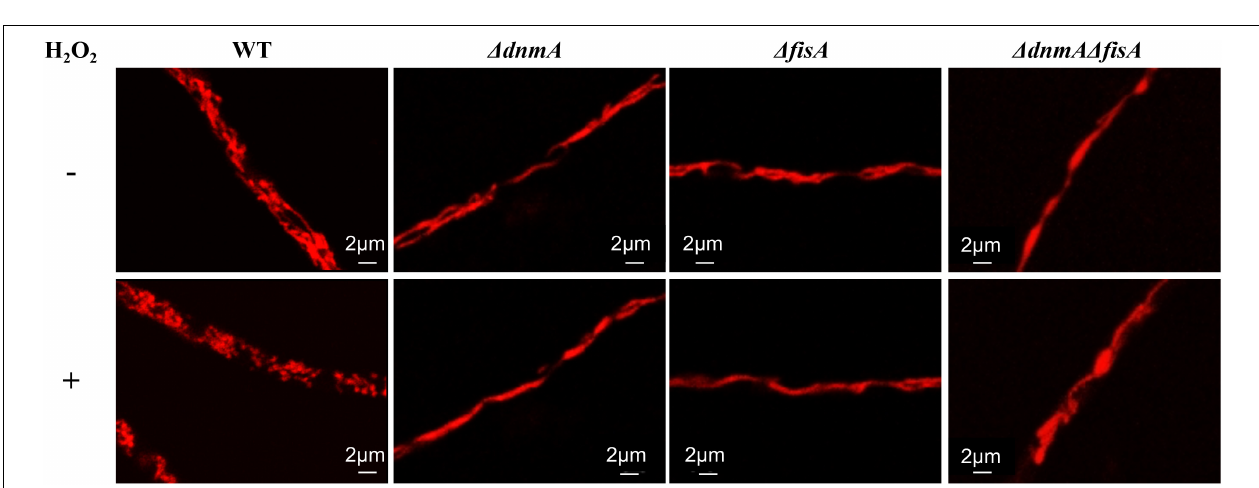
FIGURE 2 | The lack of dnmA or fisA causes severe defects in sexual development. Strains TRV1 (WT), CVG1 ( (cid:49) dnmA ), CVG2 ( (cid:49) fisA ), and CVG3 ( (cid:49) dnmA (cid:49) fisA ) were induced to undergo sexual development as previously reported (Kawasaki et al., 2002). Intact (upper panel) or crushed Cleistothecia (middle and lower panels) from 8-day old cultures were isolated and observed under the microscope. White arrows point to ascogenous tissue (middle panel) and ascospores (lower panel).